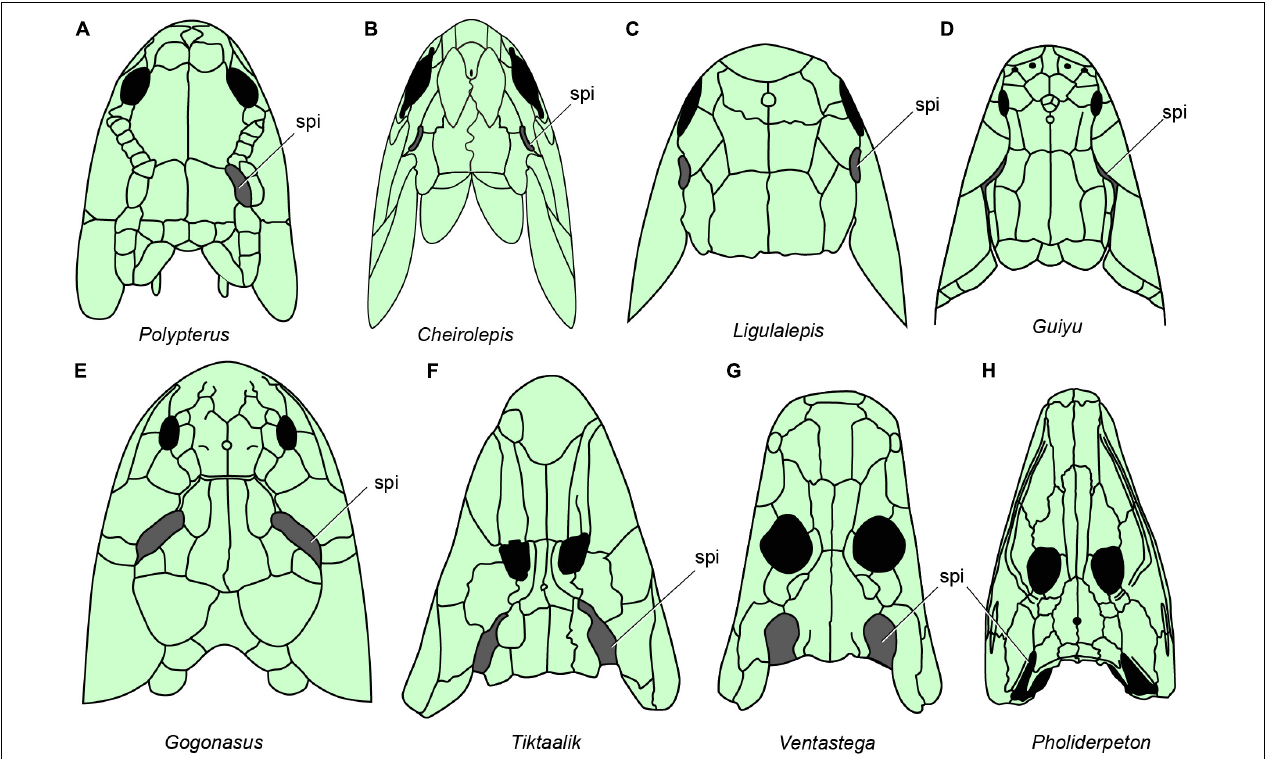
FIGURE 6 | The distribution of spiracles in bony fishes and tetrapods. (A) Polypterus redraw after (Graham et al., 2014). (B) Cheirolepis redraw after (Pearson and Westoll, 1979). (C) Ligulalepis redraw after (Basden and Young, 2001). (D) Guiyu redraw after (Zhu et al., 2009). (E) Gogonasus redraw after (Long et al., 2006). (F) Tiktaalik redraw after (Daeschler et al., 2006). (G) Ventastega redraw after (Ahlberg et al., 2008). (H) Pholiderpeton redraw after (Clack, 2012), (A–H) , in dorsal view.